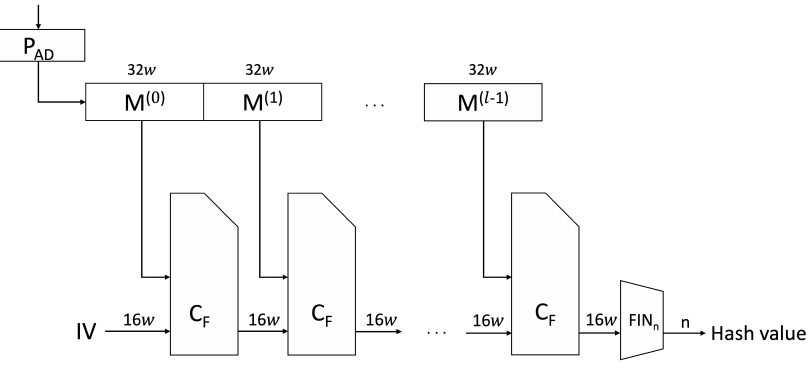
Figure 1. Overview of LSH hash